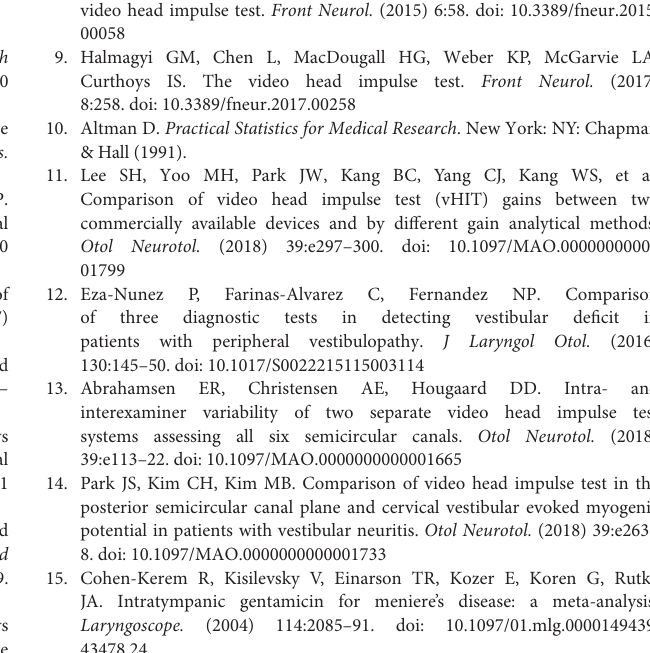
Supplementary Table 1 | Measured gain from each individual in study part 1 and 2. Supplementary Video 1 | Recording the vertical movements in space from different parts of the googles, while performing vertical movements as specified by the manufacturers, with Zebris © 3D ultrasound tracking